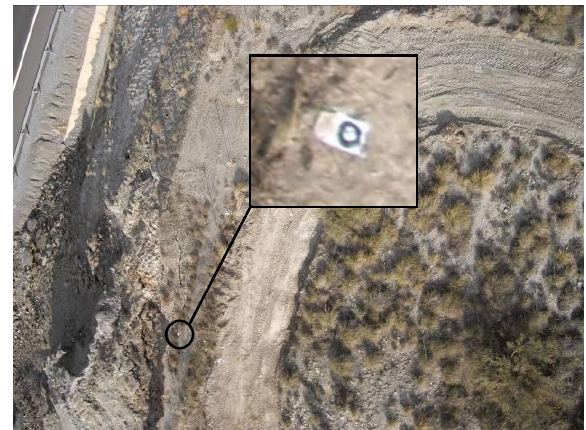
Figure 13. Detail of one of the 29 target points zoomed from a photo of the photogrammetric project